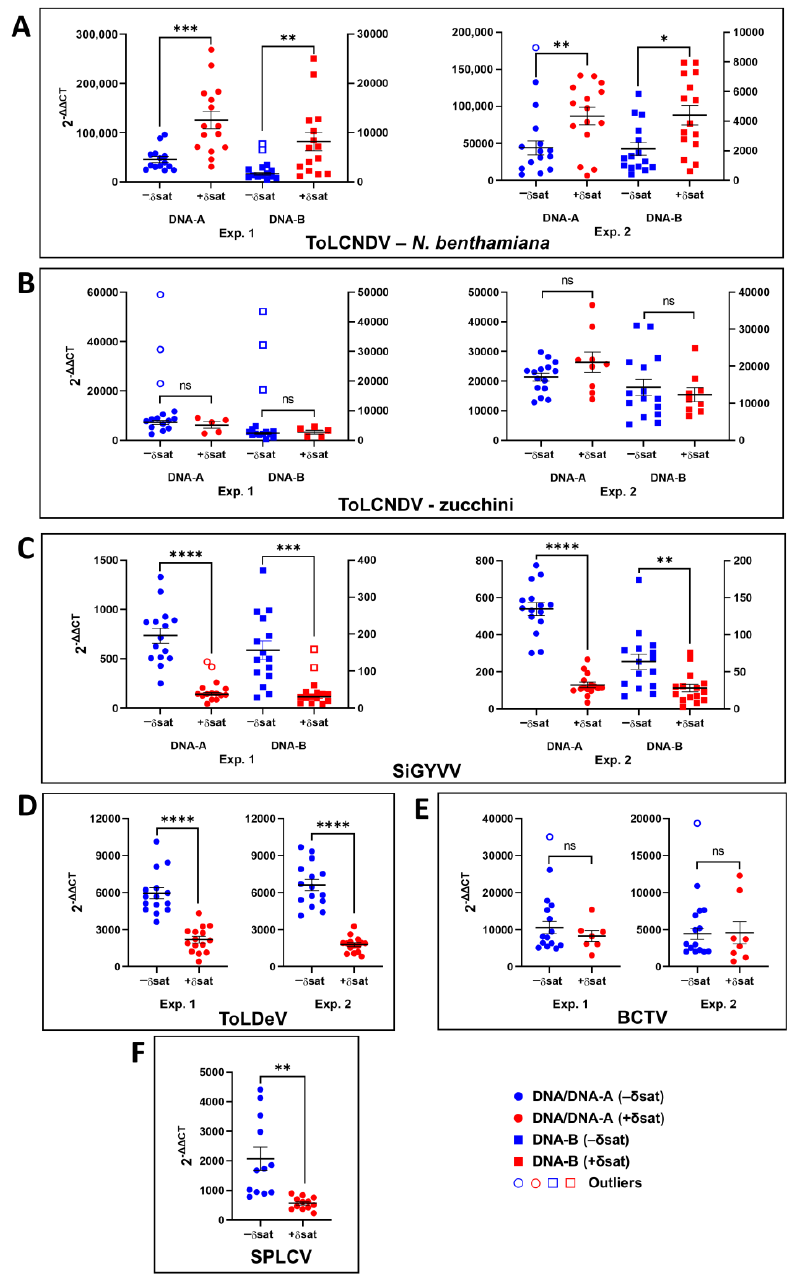
Figure 7. Relative quantification by real-time PCR of helper geminivirids alone (– δ sat) or in combi- nation with sweet potato leaf curl deltasatellite 1 (+ δ sat). ( A , B ) Tomato leaf curl New Delhi virus (ToLCNDV) DNA-A and DNA-B in Nicotiana benthamiana and zucchini, respectively. ( C ) Sida golden yellow vein virus (SiGYVV) DNA-A and DNA-B, ( D ) tomato leaf deformation virus (ToLDeV) DNA, ( E ) beet curly top virus (BCTV) DNA, and ( F ) sweet potato leaf curl virus (SPLCV) DNA in N. benthamiana . Data (2 − ∆∆ CT , Table S6) correspond to plants agroinoculated in two independent experiments (Exp.1, Exp.2) analyzed at 30 days post-inoculation. For SPLCV, included as a control, only Experiment 1 was analyzed. Each circle (DNA/DNA-A) and square (DNA-B) represents one infected plant. Open circles and squares correspond to outlier values. Mean and standard error values are indicated in each graph. Significant differences are labelled with asterisks (n.s., p > 0.05; *, p ≤ 0.05; **, p ≤ 0.01; ***, p ≤ 0.001; ****, p ≤ 0.0001). Additional details of the statistical analysis are provided in Table